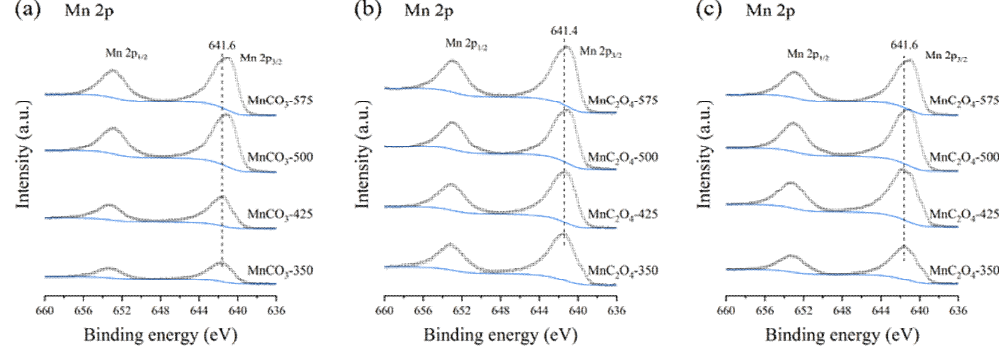
Figure 5. XPS spectra of Mn 2p for the manganese oxide catalysts obtained by calcining ( a ) MnCO 3 , ( b ) MnC 2 O 4 and ( c ) Mn(OH) 2 .